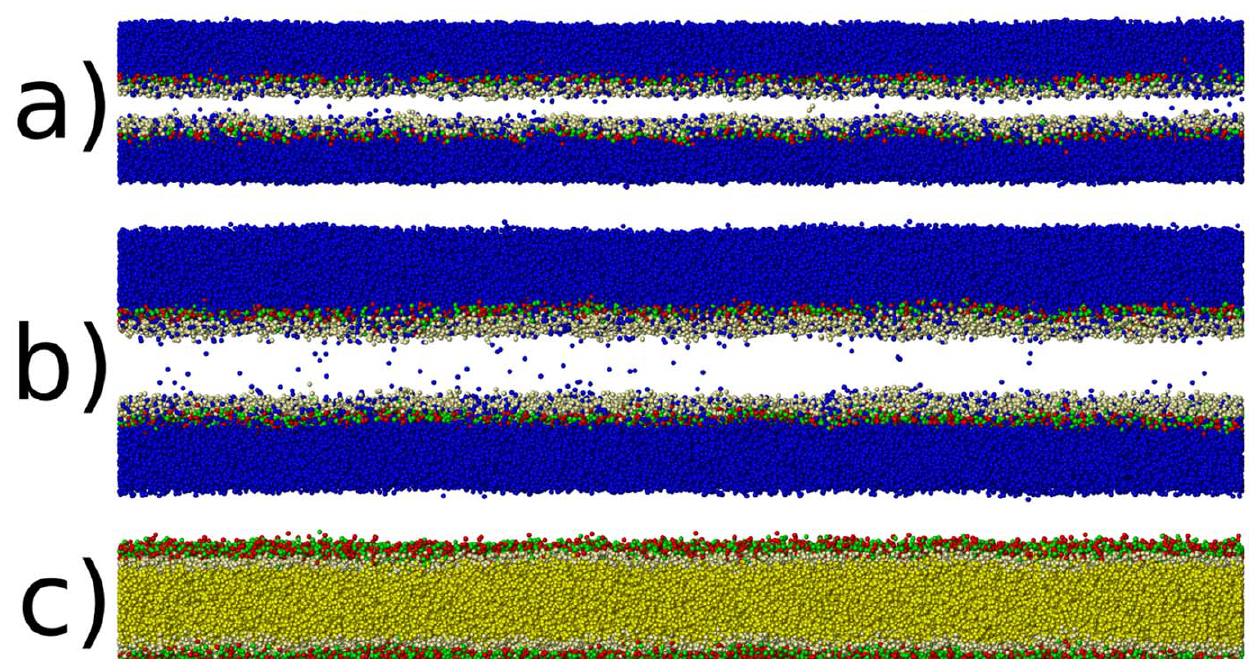
Figure 11. Simulation snapshots for the shock experiment with v p ~ 1023 m/s. a) shows the the lipid bilayer at maximum compression. Only water (blue) and the hydrophilic head groups of the lipids (red, green, and beige) are shown. The hydrophobic tails of the lipids are not shown in order to facilitate the visualization of water within the lipid bilayer. b) shows the unloaded state after 2500 ps. Note the smaller amount of water introduced into the bilayer compared to part c) of Fig. 10. c) also shows the final state after unloading, but here only lipids with their tails (yellow) are shown but no water. Note that there are no lipids which have reversed direction due to shock-loading, in contrast with the faster shock experiment. three Cartesian directions. All particles were assigned a constant